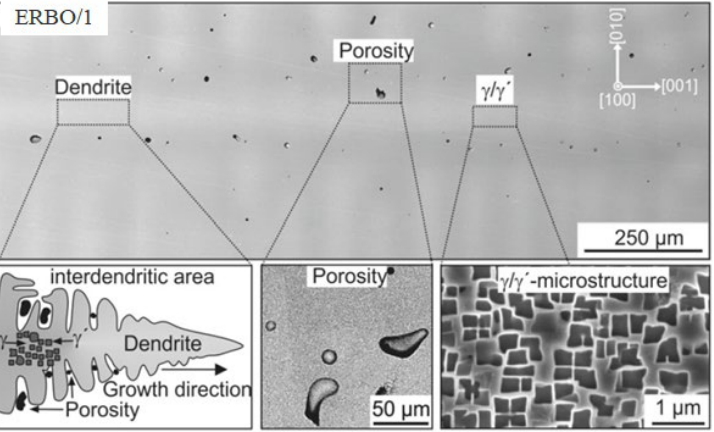
Figure 1. As-cast microstructure of nickel-based SX superalloy ERBO/1 [34] .